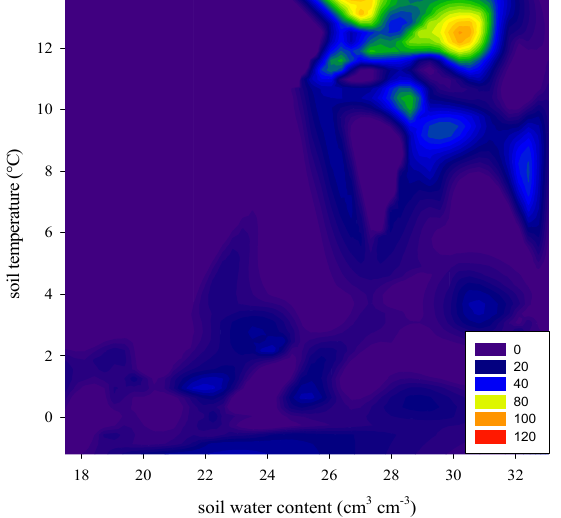
Figure 6. Relationship between nitrous oxide (N 2 O) flux and soil temperature and soil water content in top soil layers.